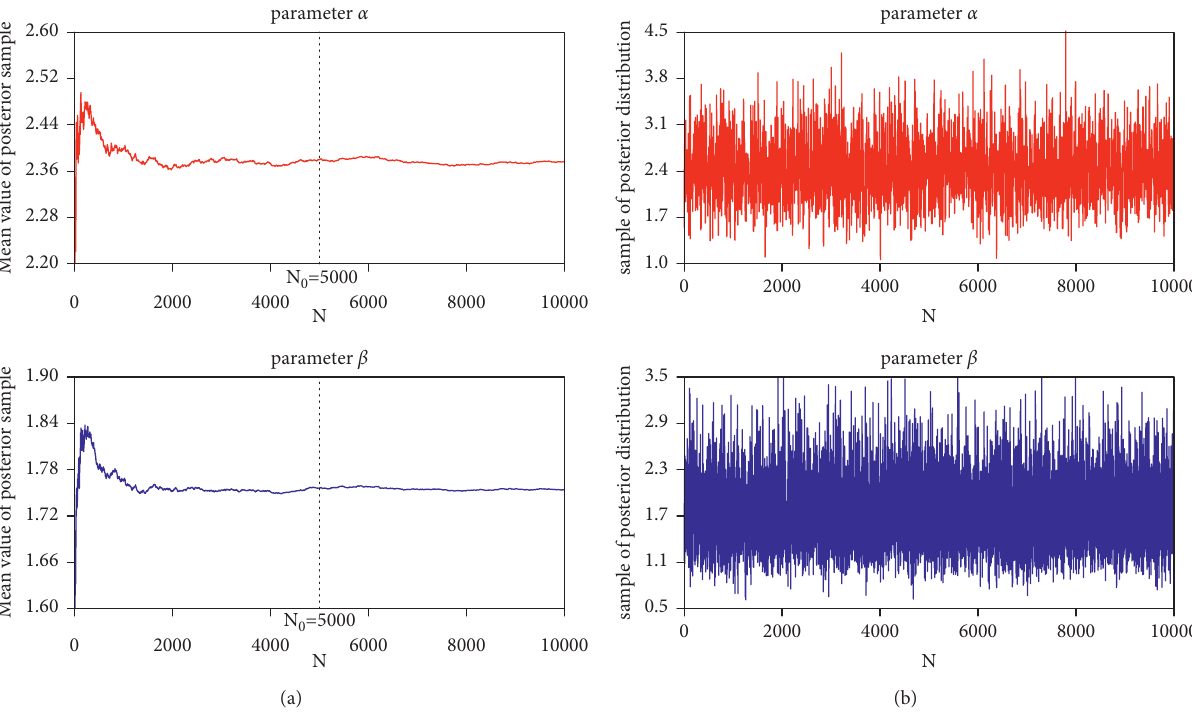
Figure 5: The iterative trend plots (a) and the trace plots (b) of sampling algorithm for parameter α and β under ball-bearings failure